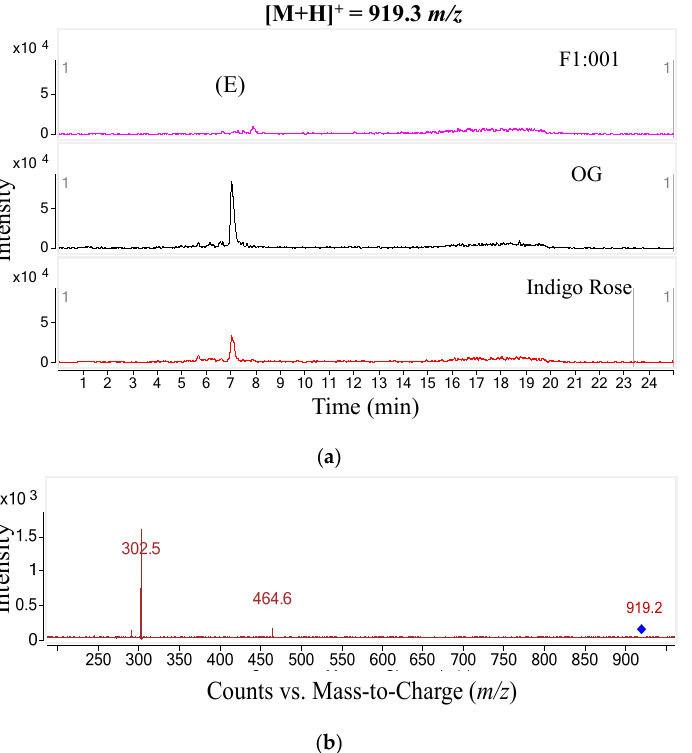
Figure 7. Chromatogram ( a ) and MS–MS fragments ( b ) of [M+H]+ ion with 963.3 m / z in three tomato varieties.